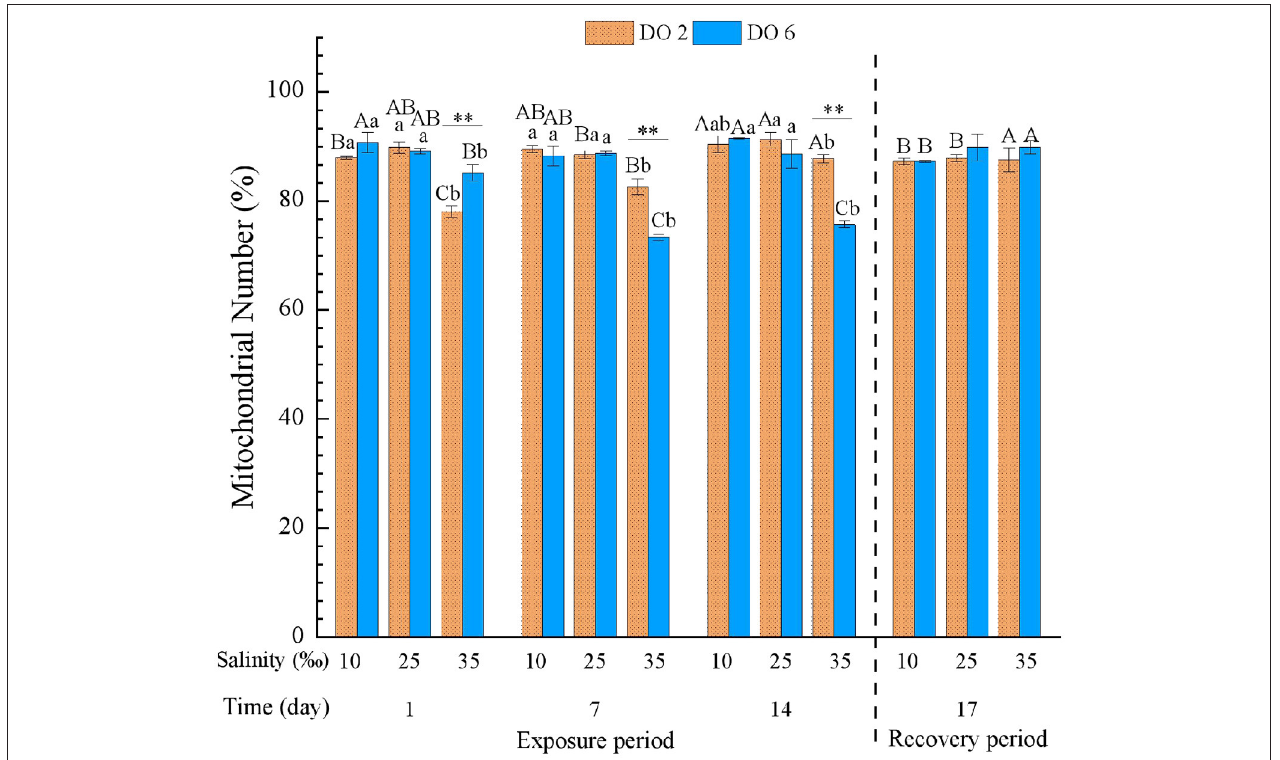
FIGURE 6 | Mitochondrial number (MN) of C. hongkongensis exposed to six combinations of salinity (10, 25, and 35 ‰ ) and DO (2 and 6 mg/L) at 1, 7 and 14 days during the exposure period and 3 days for the recovery period. Different capital letters indicate significant differences among time points within each salinity level in hypoxia level (2 mg/L) or control group (6 mg/L) ( p < 0.05). Different small letters indicate significant differences between salinity within each time point in salinity level in hypoxia level (2 mg/L) or control group (6 mg/L) ( p <